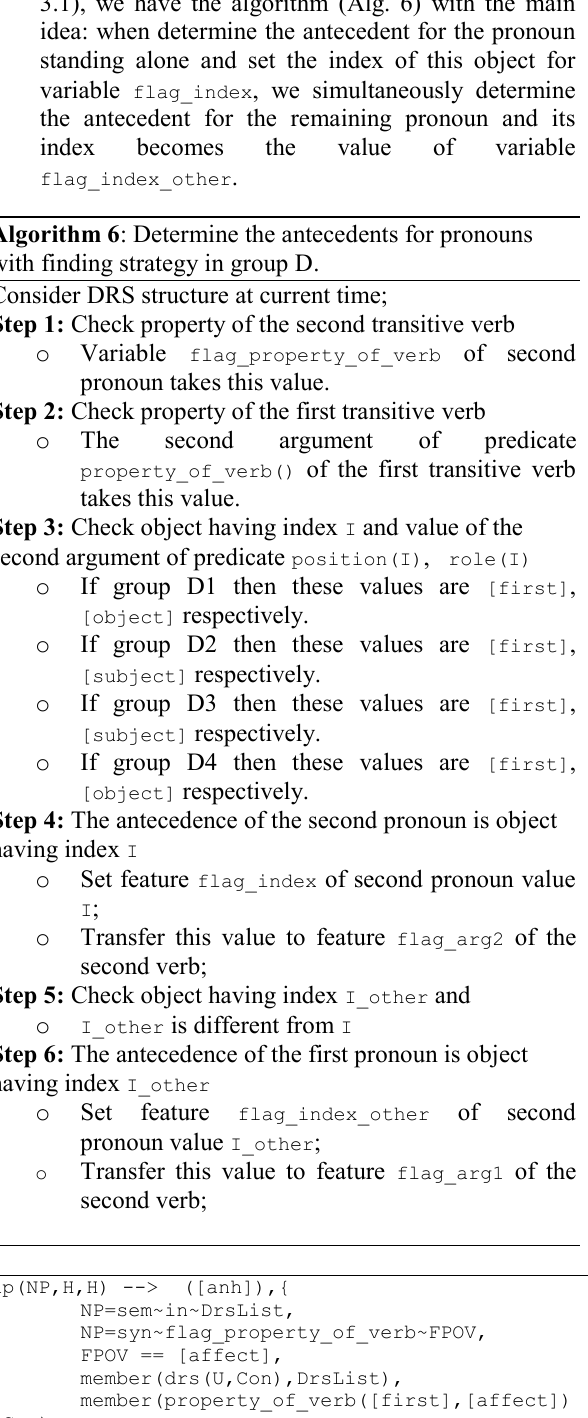
Figure 18. Implement Algorithm 5 based on framework GULP